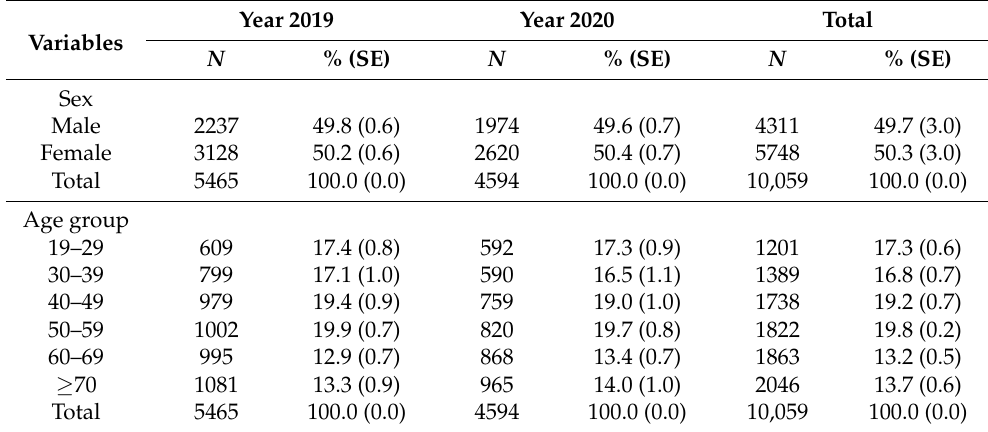
Table 1. Demographic characteristics in Korean adults aged 19 and older.